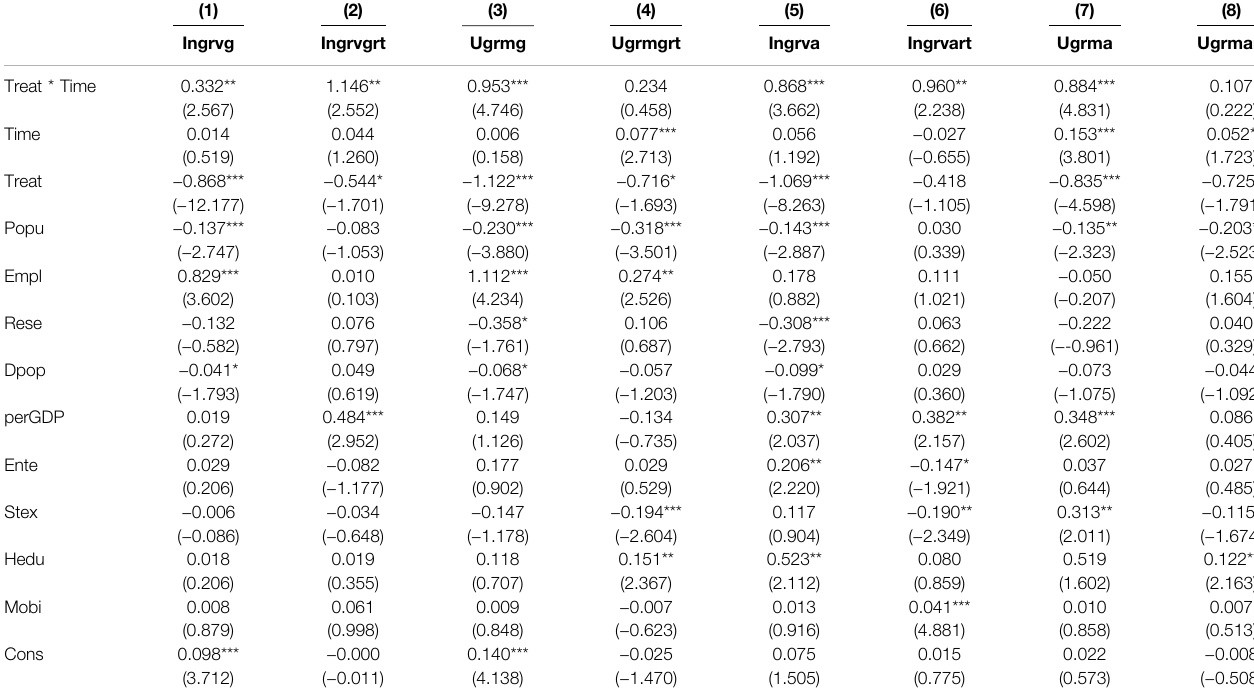
TABLE 7 | Regression results after